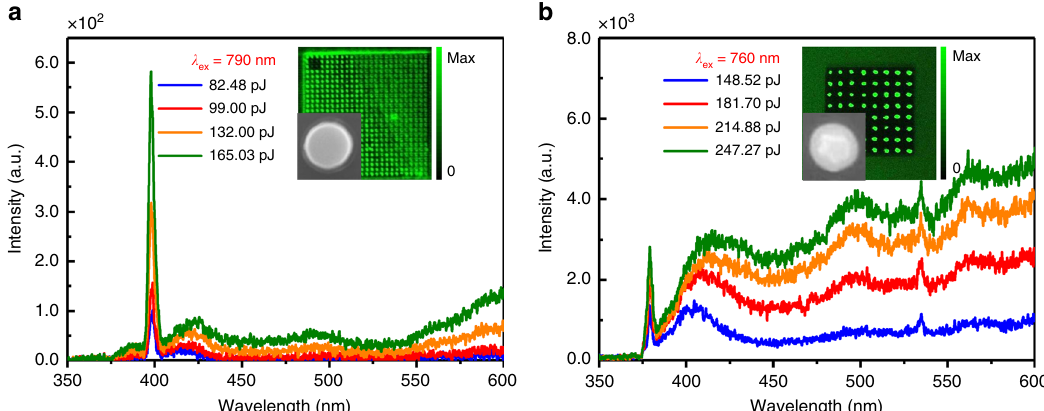
Fig. 4 White-light emission from silicon nanopillars. a Nonlinear response spectra measured for a silicon nanopillar (NP), which is excited at the magnetic dipole resonance, at different pulse energies. b Nonlinear response spectra measured for a single truncated silicon nanocone (NC), which is excited at the electric dipole resonance, at different pulse energies. The insets show the emission patterns of the array of silicon NPs obtained by using a laser scanning confocal microscope. In each case, the scanning electron microscope image for a single silicon NP or NC is also provided as an inset